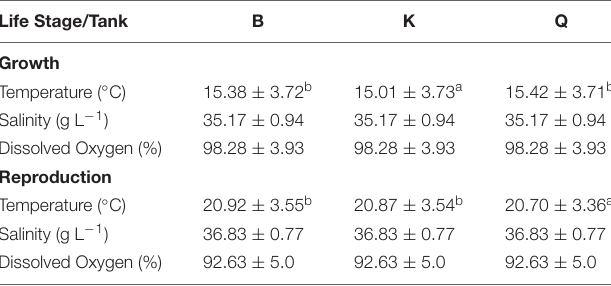
TABLE 2 | Mean Wet Weight (MWW), Mean Absolute IGR (MAIGR), Total Absolute Mortality (TAM), Mean Cumulative Mortality (MCM), Biomass (Bm), Mean Biomass